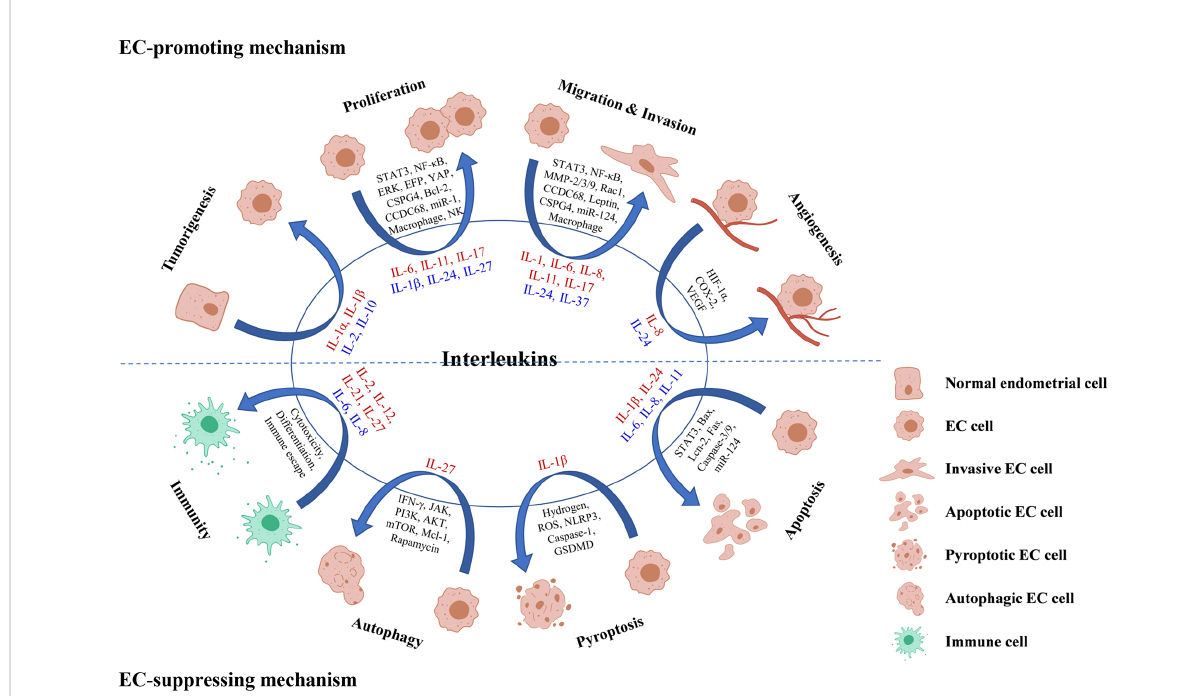
FIGURE 2 Roles and mechanisms of interleukins in EC oncogenesis and progression. Interleukin in red color means that it exerts a promoting effect on the process, while interleukin in blue color means that it exerts a suppressing effect on the